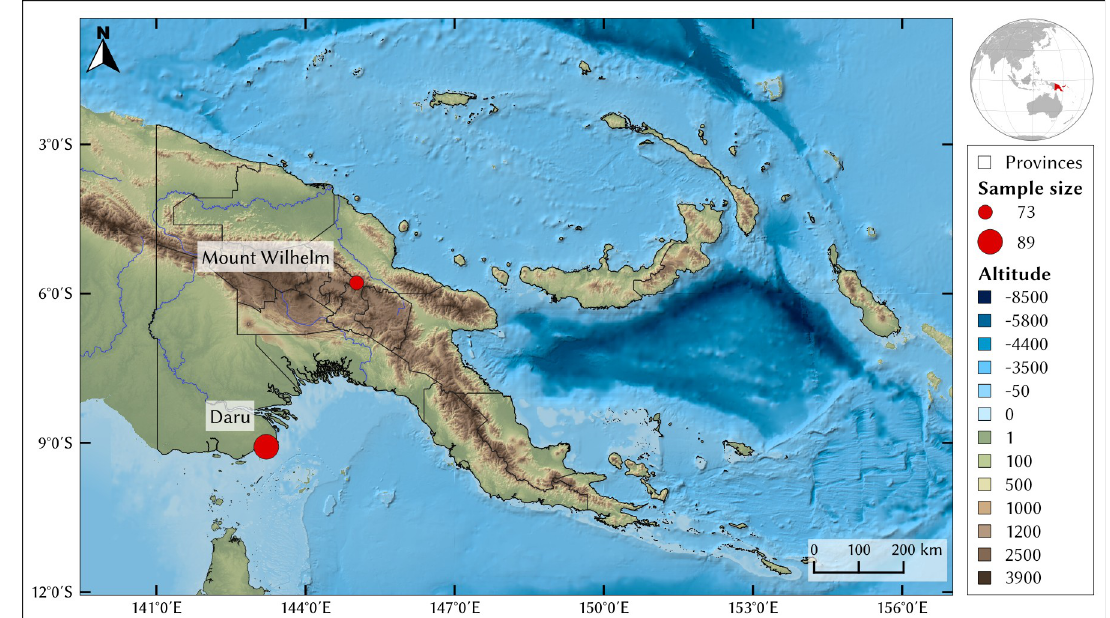
Fig 1. Map of the sampling locations. Map: Se´bastien Plutniak/QGIS 3.14.16. Projection: EPSG 4326. DOI: 10.5281/zenodo.3911844. Sources: digital elevation model: GEBCO [46].